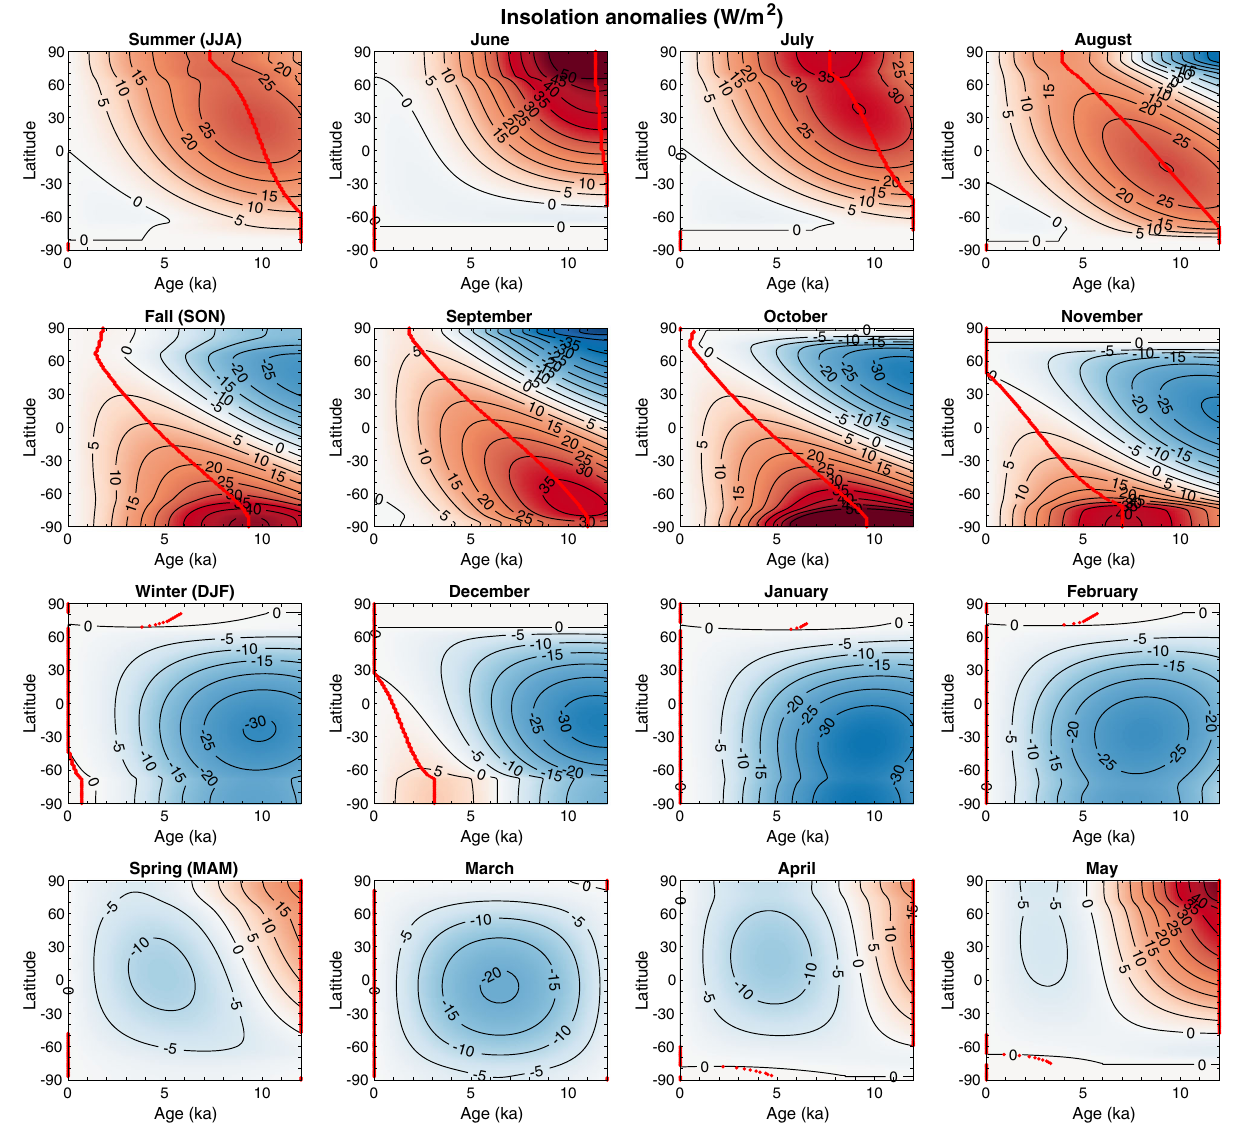
Fig. 9 | Seasonal and monthly insolation. Seasonal and monthly insolation anomalies compared to modern insolation (W/m 2 ) based on orbital parameters 48